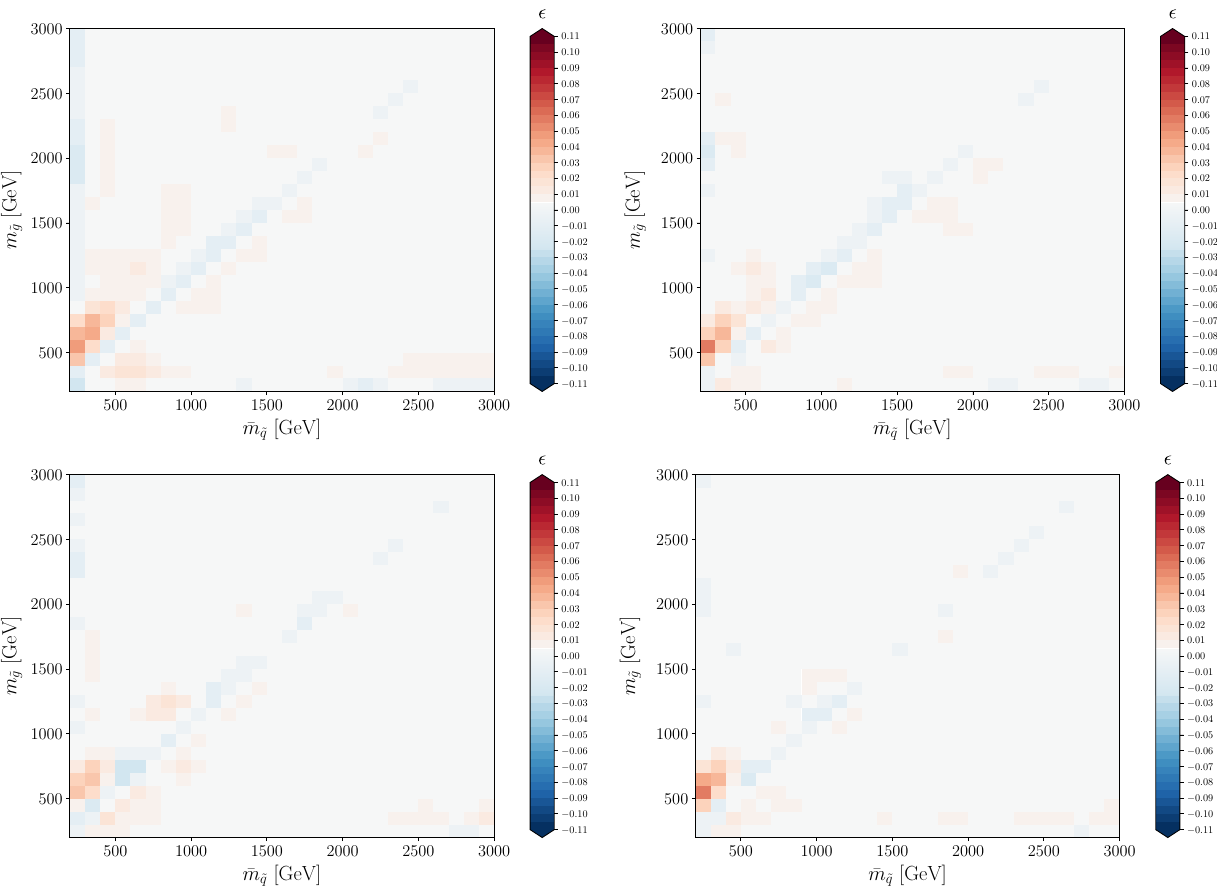
Fig. 12 The relative error of the production cross-section for gluinos and first or second-generation squarks, as a function of the average mass of first and second-generation squarks and the mass of the gluino.